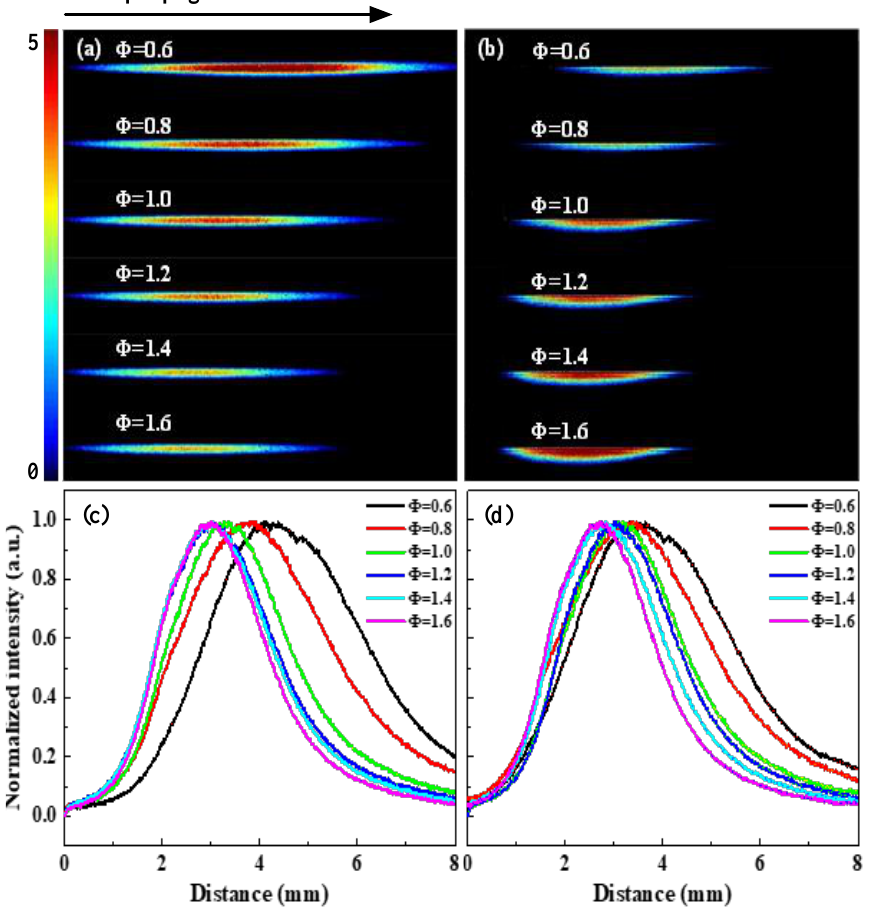
Figure 6. ( a ), Spectral image of N 2 (337 nm) with different equivalence ratios. ( b ), Spectral images of C 2 (516.5 nm) with different equivalence ratios. ( c ), Spatial distribution curves of N 2 (337 nm) with different equivalence ratios. ( d ), distribution curves of C 2 (516.5 nm) with different equivalence ratios.